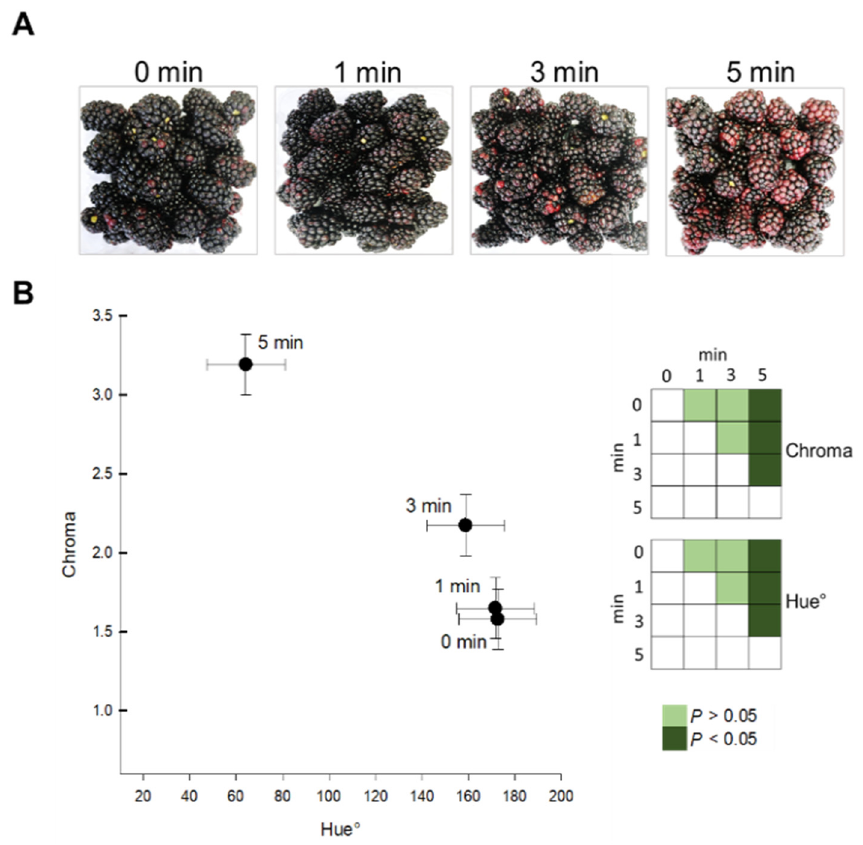
Figure 2. Vibration generated by portable vibrator system induce RDR in blackberry fruit. ( A ) Color change induced by different vibration times (10 Hz and 0.5 g’ s). ( B ) Hue° and chroma parameters in blackberries vibrated at different times. Left panel depicts mean values ± SE ( n = 15). Right panel depicts pairwise comparisons for statistical analysis (Tukey test).